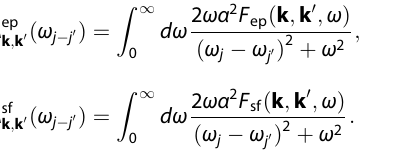
(cid:1) K 0 (cid:1) K 0 (blue), and K o − K o plus K 0 (green) i i o o